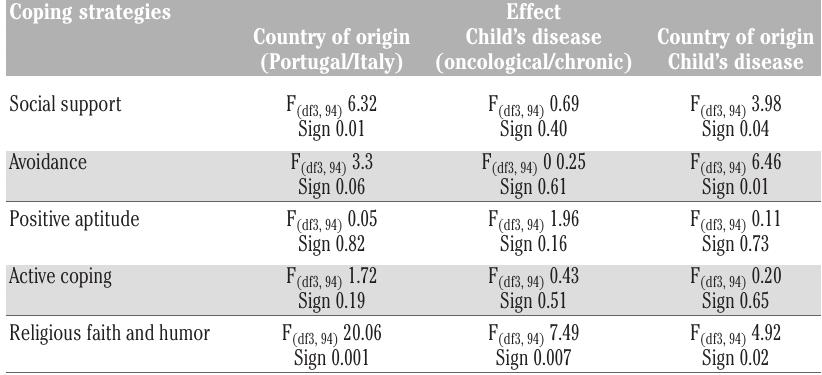
Table 2. Mother’s coping strategies: between-subjects test